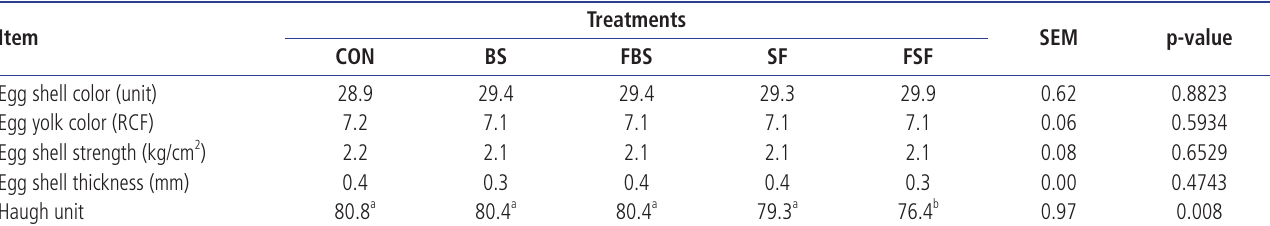
Table 4. Effects of dietary supplementation with non-fermented or fermented by-products of brown seaweed and seaweed fusiforme on egg and eggshell characteristics in laying hens